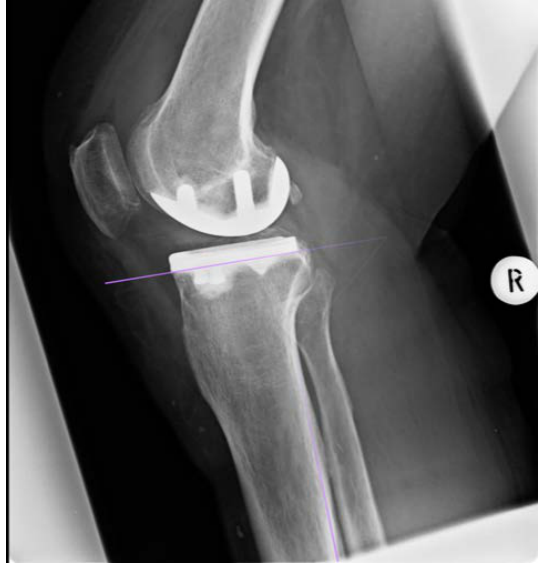
Figure 5. Illustration of the measurement process. For determining the posterior slope, a tangent was drawn next to the posterior cortical axis, another one next to the lower border of the tibial component. In this case the posterior inclination was 87.5°.